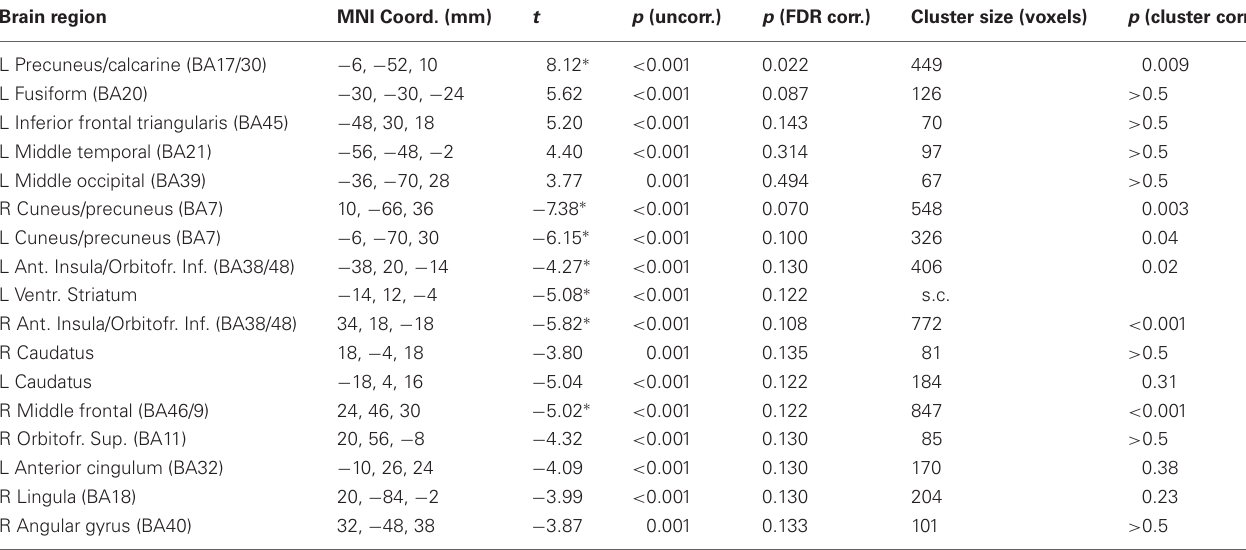
Table 7 | Interaction between emotion and abstraction, whole brain analysis. Brain region MNI Coord.